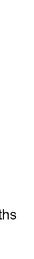
Figure 2. The differences between 3 and 12 months. In each figure, on the ordinate axis, the mean of the domain scores is indicated, and on the abscissa axis, the difference between 3 and 12 months. PF: Physical functioning. BP: Bodily pain. RP: Physical role. SF: Social functioning. VT: Vitality. RE: Emotional role. GH: General health. MH: Mental health. PCS: Physical component summary score. MCS: Mental component summary score.